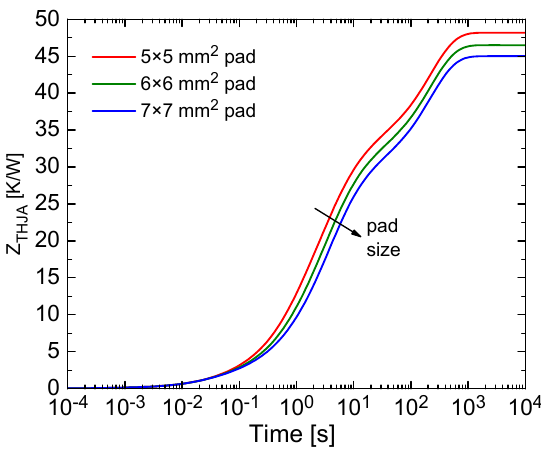
Figure 7. Thermal impedance Z THJA against time of a 10 × 10 mm 2 pLQFP with a 4 × 4 mm 2 die for three different pad sizes.